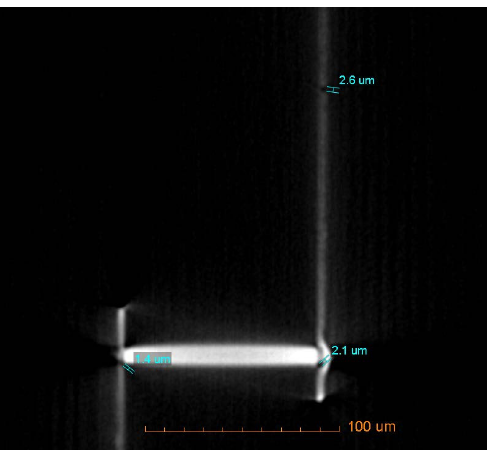
Figure 13. Fracture morphology of the metal layer observed in XY section.